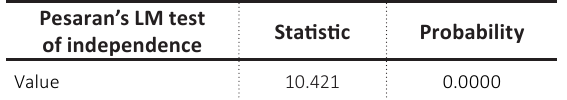
Table 11. Pesaran’s test of cross-sectional independence